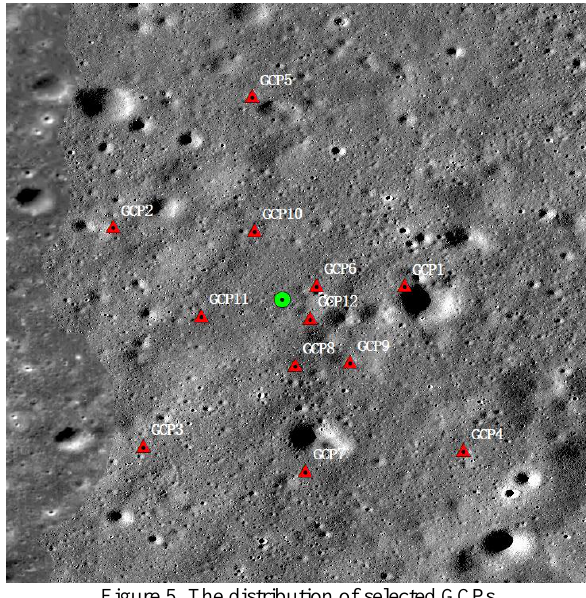
Figure 5. The distribution of selected GCPs The Cartesian coordinates of the selected GCPs are list below: